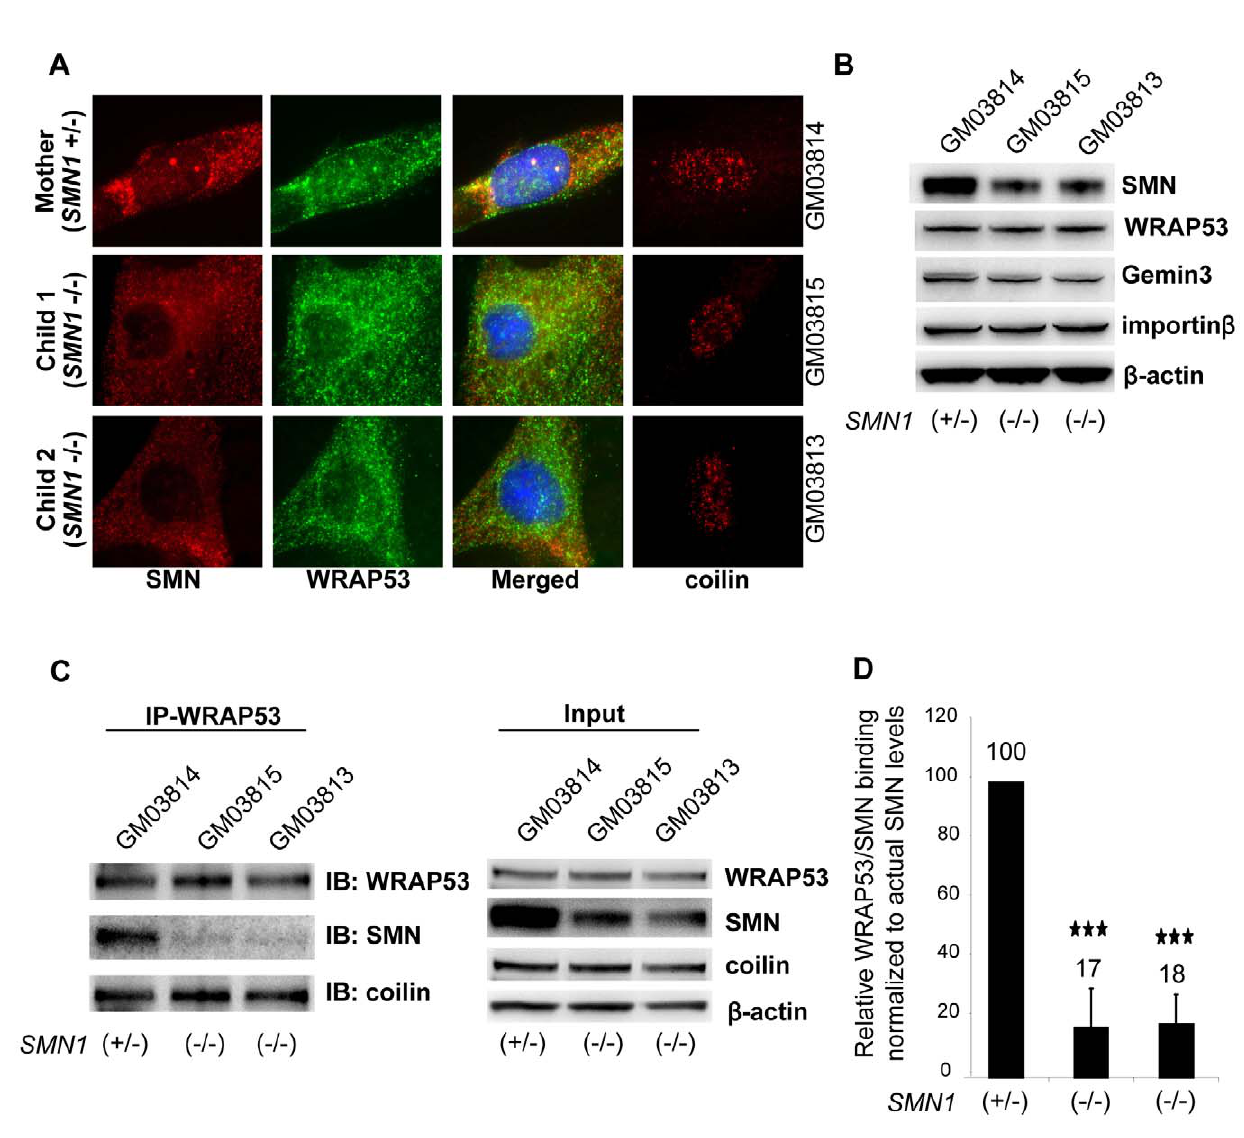
Figure 7. Interaction of WRAP53 and SMN is disrupted in SMA type I patients. (A) IF staining of SMN, WRAP53, and coilin in fibroblasts derived from the unaffected mother (GM03814) and her two children with SMA type I (GM03815 and GM03813). (B) WB analysis of WRAP53, SMN, Gemin3, and importin b levels in fibroblasts from the same individuals as described in (A). b -actin was used as loading control. (C) IP of endogenous WRAP53 from the same fibroblasts described in (A). (D) Densitometric quantifications of the relative WRAP53–SMN interaction in the fibroblasts described in (A). Levels of SMN co-immunoprecipitated with WRAP53 antibody have been normalized to the levels of immunoprecipitated WRAP53, as well as to the relative amount of SMN in the cells. The latter was calculated by dividing SMN levels in the input with b -actin levels in the input. The graph shows means of three independent experiments; error bars represent standard error, three asterisks indicate p , 0.001 (Student’s t test).